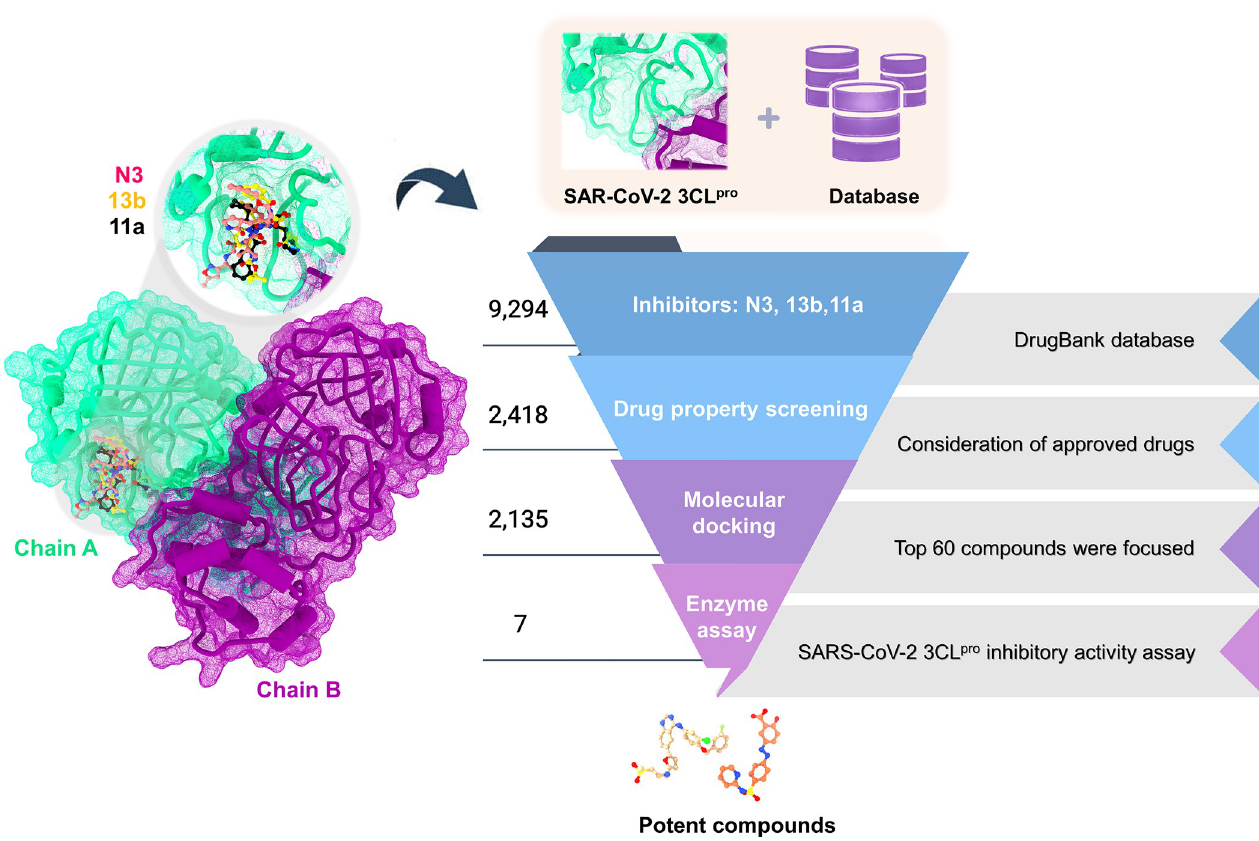
Fig 1. The virtual screening scheme of molecular docking of SAR-CoV-2 3CL pro inhibitors from the crystal structures of potent peptidomimetic inhibitors (N3, 13b, and 11a) using the DrugBank database. The screened compounds were selected, and the common drugs were later included for testing the SAR-CoV-2 3CL pro inhibitory activity by enzyme-based